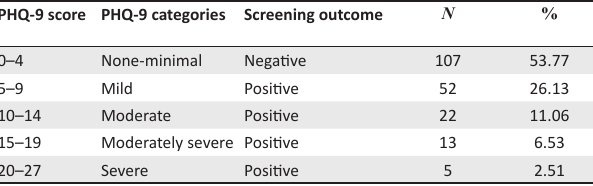
TABLE 2: Screening outcomes for depressive features using patient health questionnaire-9 score ( N = 199). PHQ-9 score PHQ-9 categories Screening